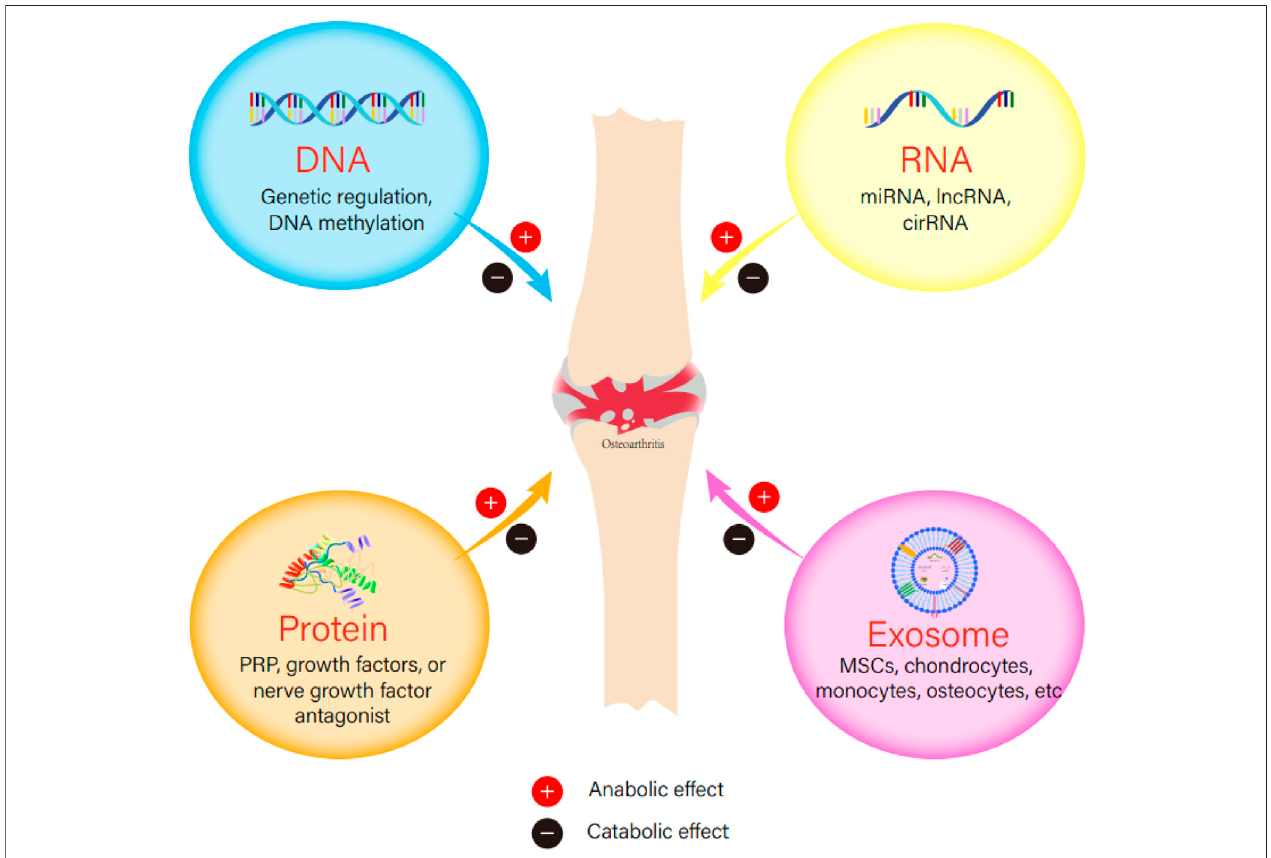
FIGURE 1 | The anabolic or catabolic effect of DNA, RNA, protein, or exosome in the initiation or development of osteoarthritis.